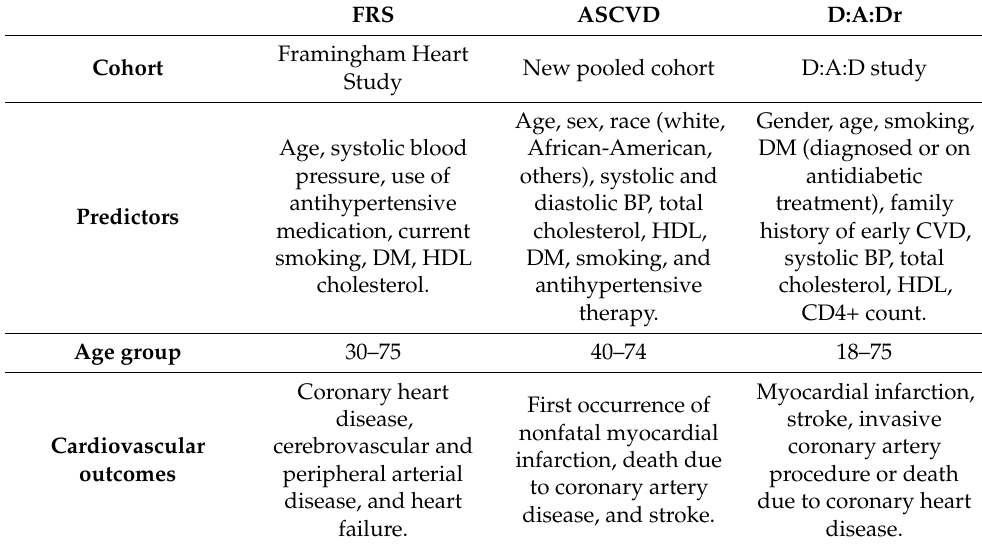
Table 1. Characteristics of CVR stratification